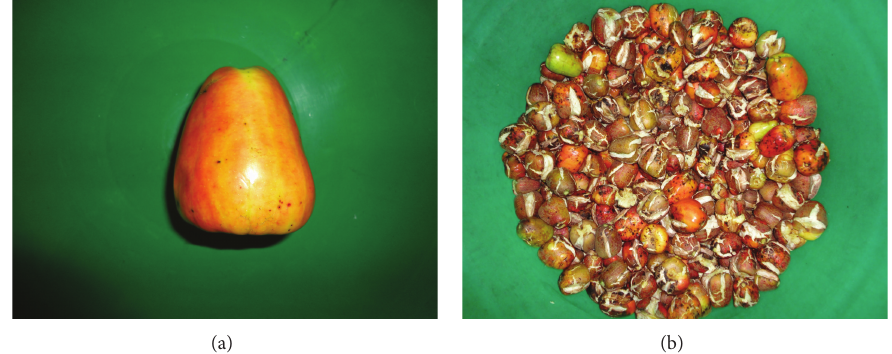
Table 1: Conditioning of HPLC for sugar analysis. Parameter Values Mobile phase (sulphuric acid) 0.001 M Flow rate Column temperature Refractive index detector temperature Injection volume Pressure 60